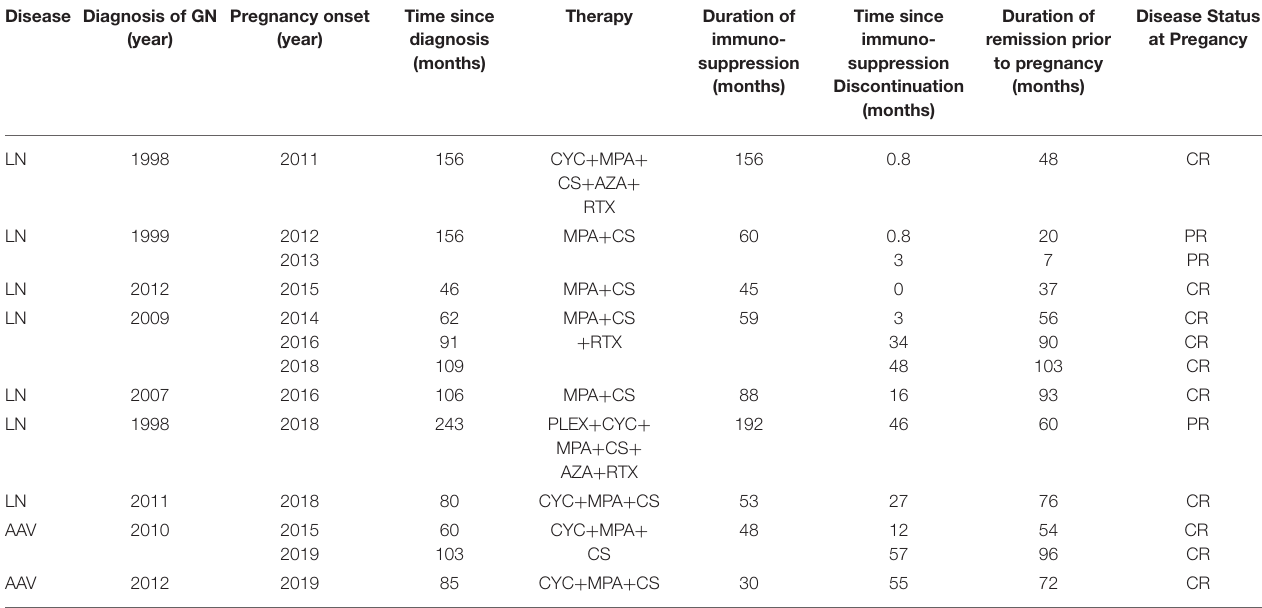
TABLE 4 | GD status and therapy from diagnosis until pregnancy. Patients with secondary GD ( n = 9). Disease Diagnosis of GN (year)